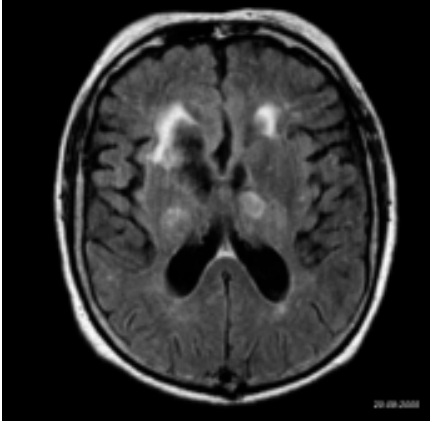
Fig. 1. Brain MRI axial FLAIR carried out five days after stroke revealing focal ischemic damage to both thalami and the right puta-